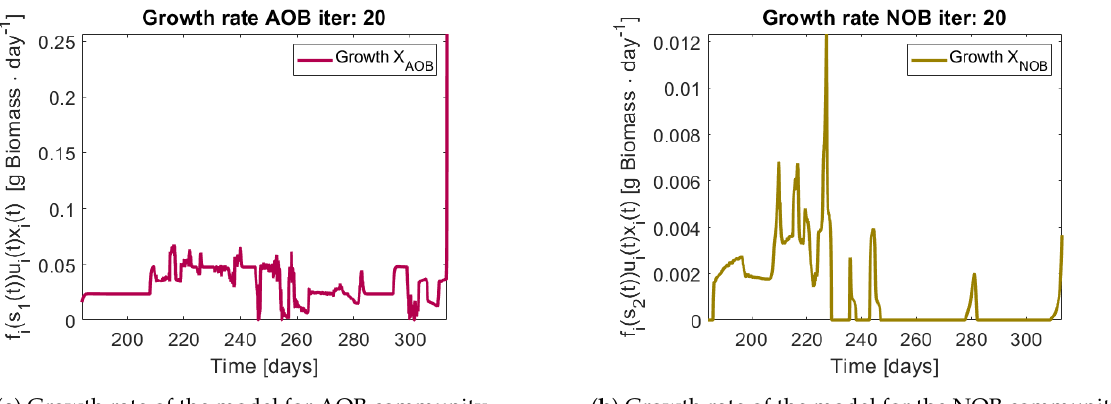
( a ) Growth rate of the model for AOB community. Figure 13. Obtained growth rates when regrouping OTU in their functional